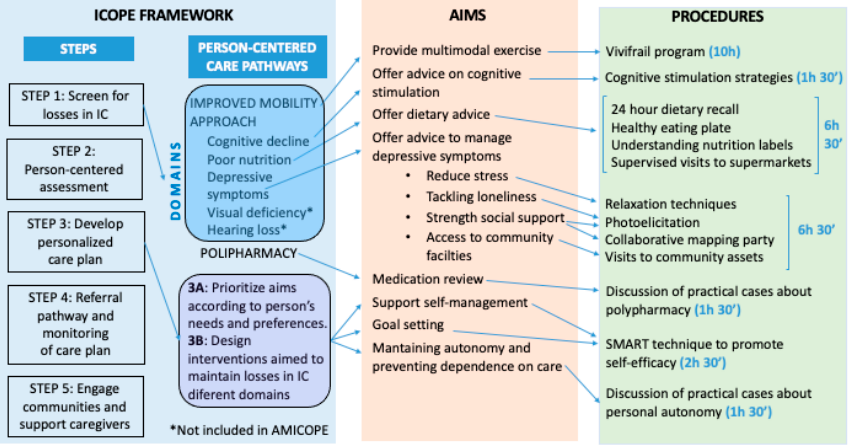
Figure 2. Conceptual framework of the AMICOPE multi-domain intervention.